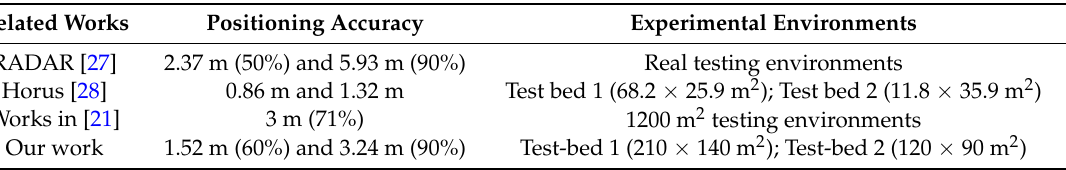
Table 4. Comparison of related